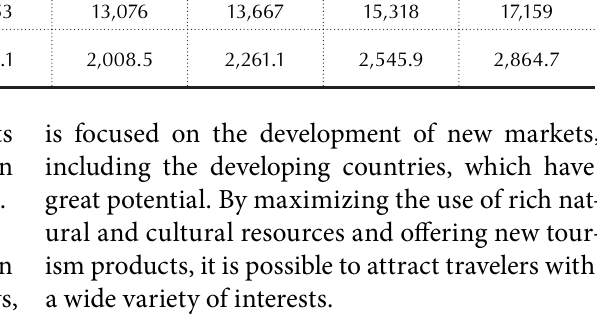
Table 3. The number of departures and passengers in 2012–2017